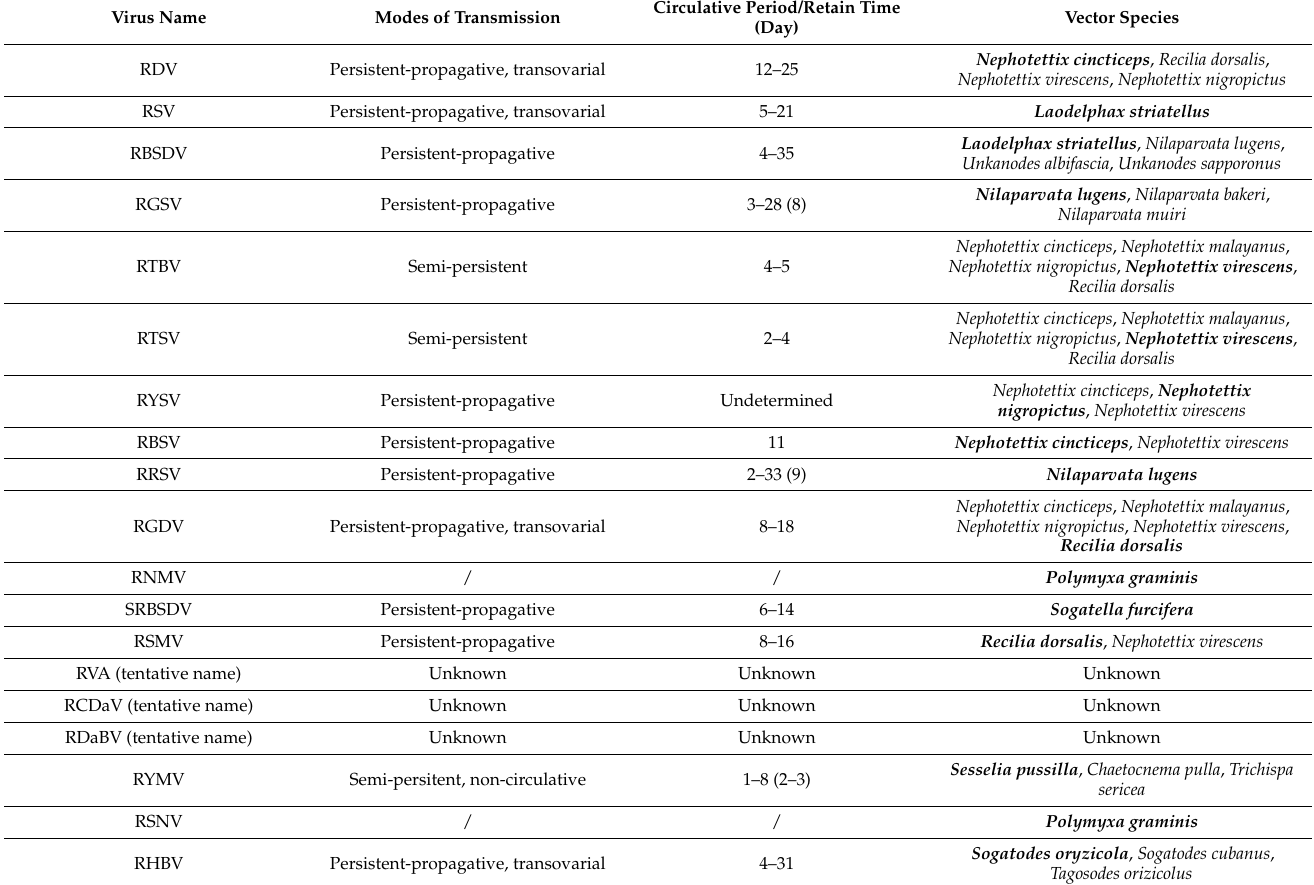
Table 3. Transmission biology of distinct rice